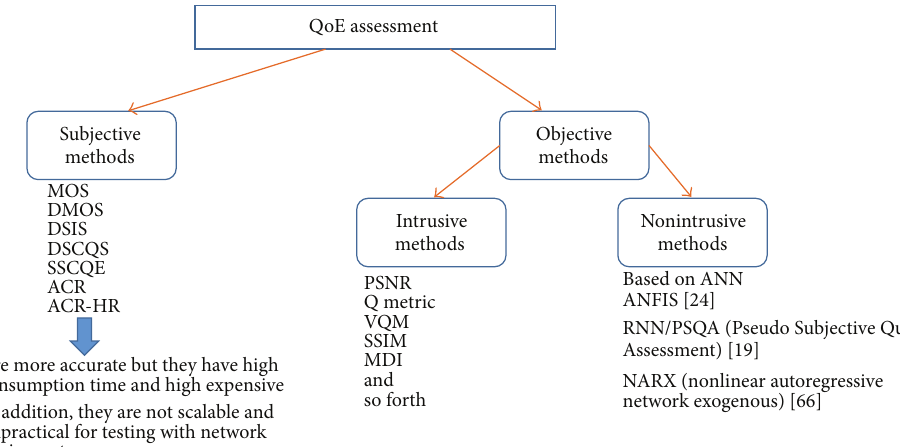
Figure 1: Methods for Quality of Experience